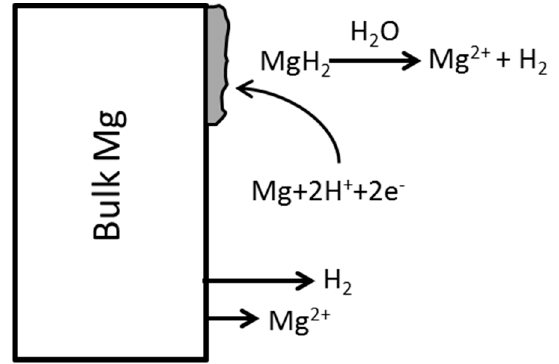
Figure 19. Magnesium hydride MgH 2 model, modified from [77]